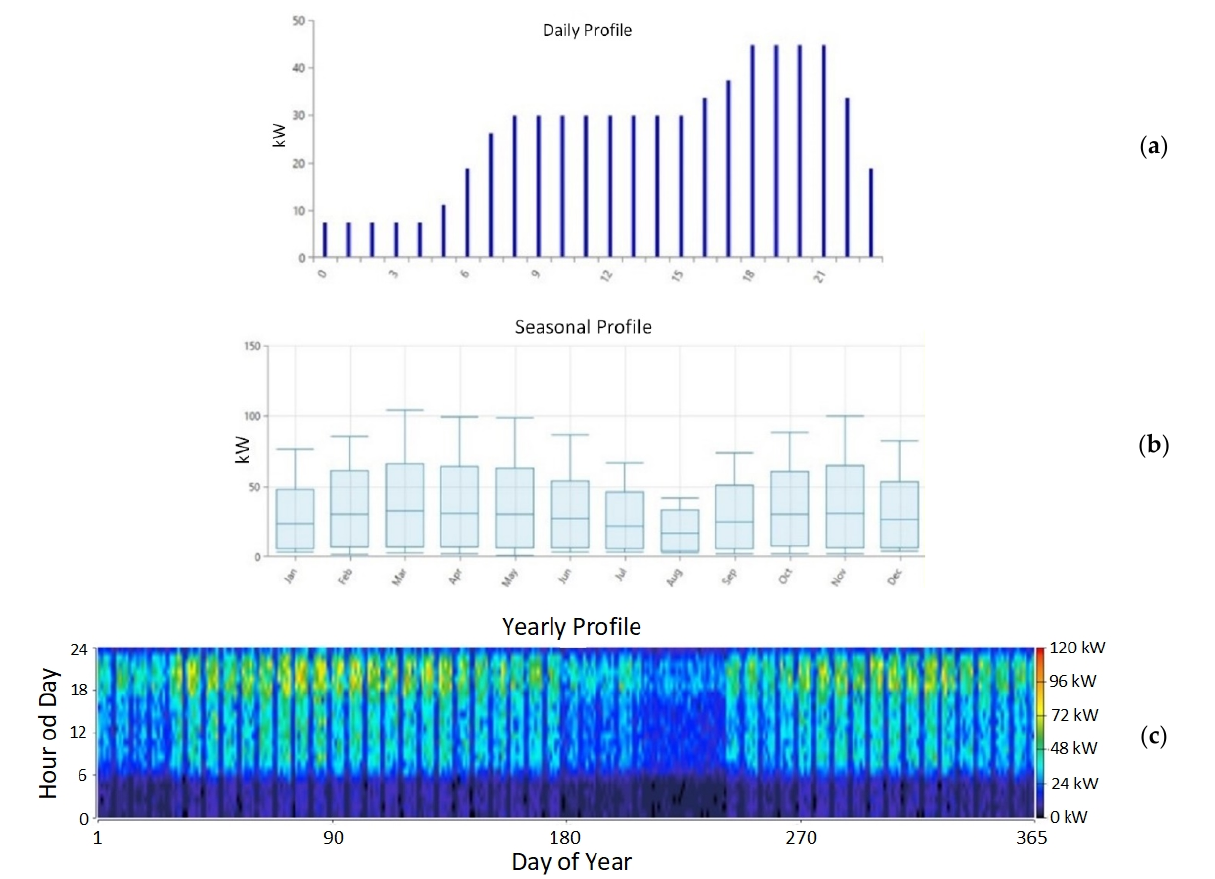
Figure 6. ( a ) Daily, ( b ) monthly, and ( c ) annual electrical energy load profile for the selected location. A more detailed monthly load profile for 2021 at the observed location is shown in Figure 7.